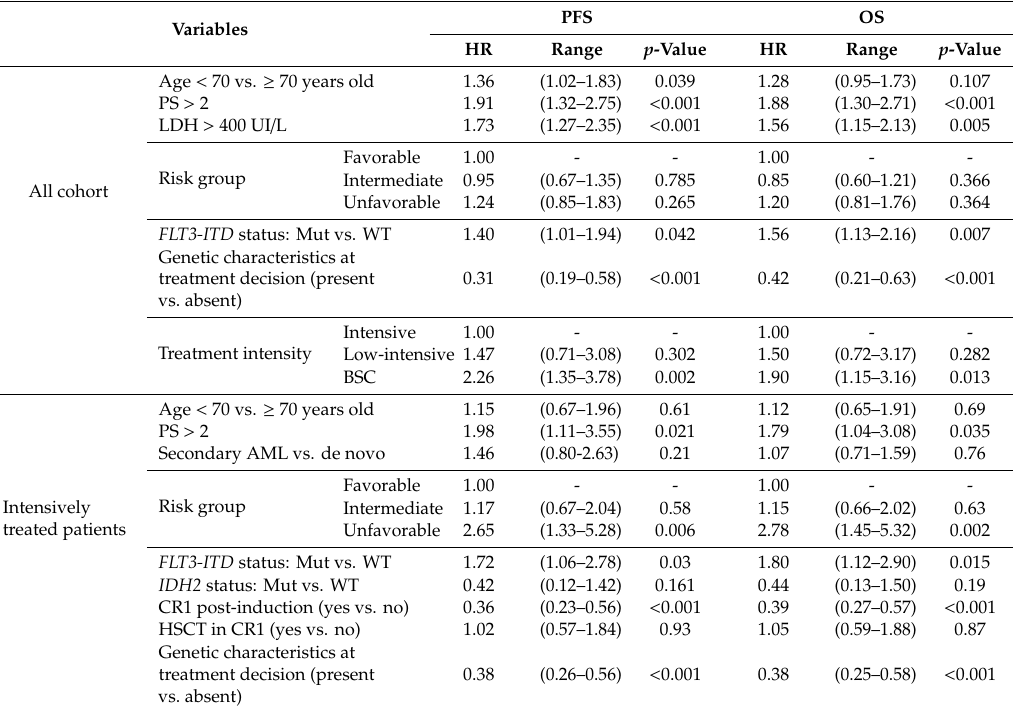
Table 4. Multivariate analysis including factors associated with survival on univariate analysis in the overall cohort and on intensively treated